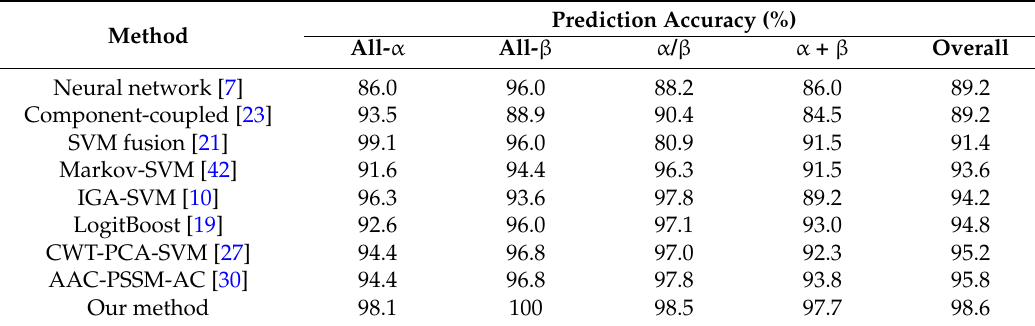
Table 3. Comparison of different methods by the jackknife test for the Z498 dataset.